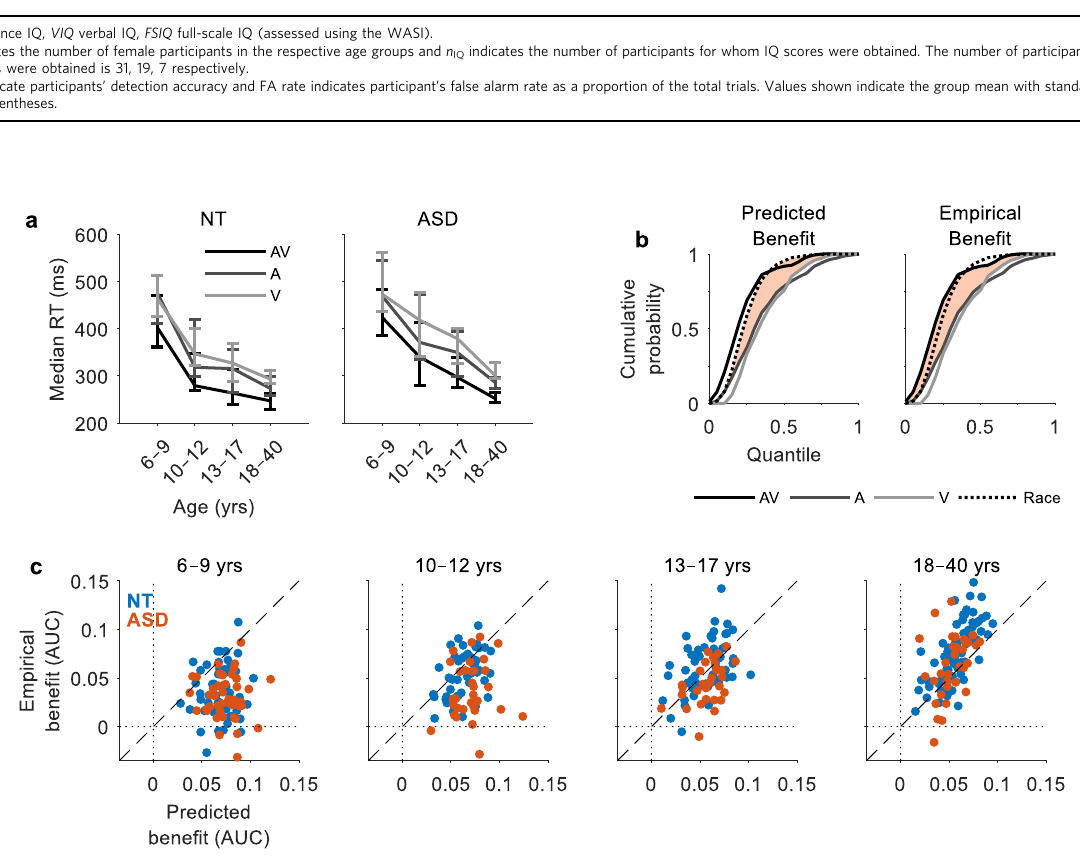
Fig. 1 Reaction times and multisensory bene fi ts. a Group median RTs for NT (left panel) and ASD (right panel) individuals as a function of age group. Error bars indicate 95% CIs (bootstrapped). b RT cumulative probability for each of the three stimulus conditions and the race model (Eq. 1). Predicted bene fi ts (left panel) are quanti fi ed by the area between the CDFs of the race model and the faster of the unisensory conditions (Eq. 3). Empirical bene fi ts (right panel) are quanti fi ed by the area between the CDFs of the multisensory condition and the faster of the unisensory conditions (Eq. 4). Data from an example NT adult participant. c Predicted bene fi ts versus empirical bene fi ts by age group. Each datapoint represents the area under the curve (AUC) for an individual participant (blue = NT, red =